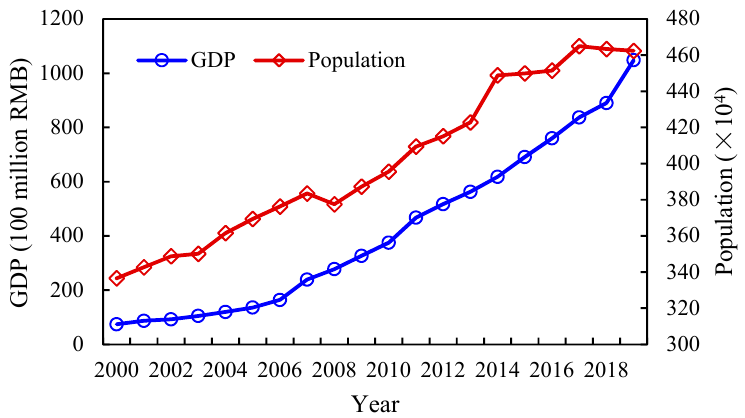
Figure 11. Gross domestic product (GDP) and population in Kashgar region from 2000 to 2019.